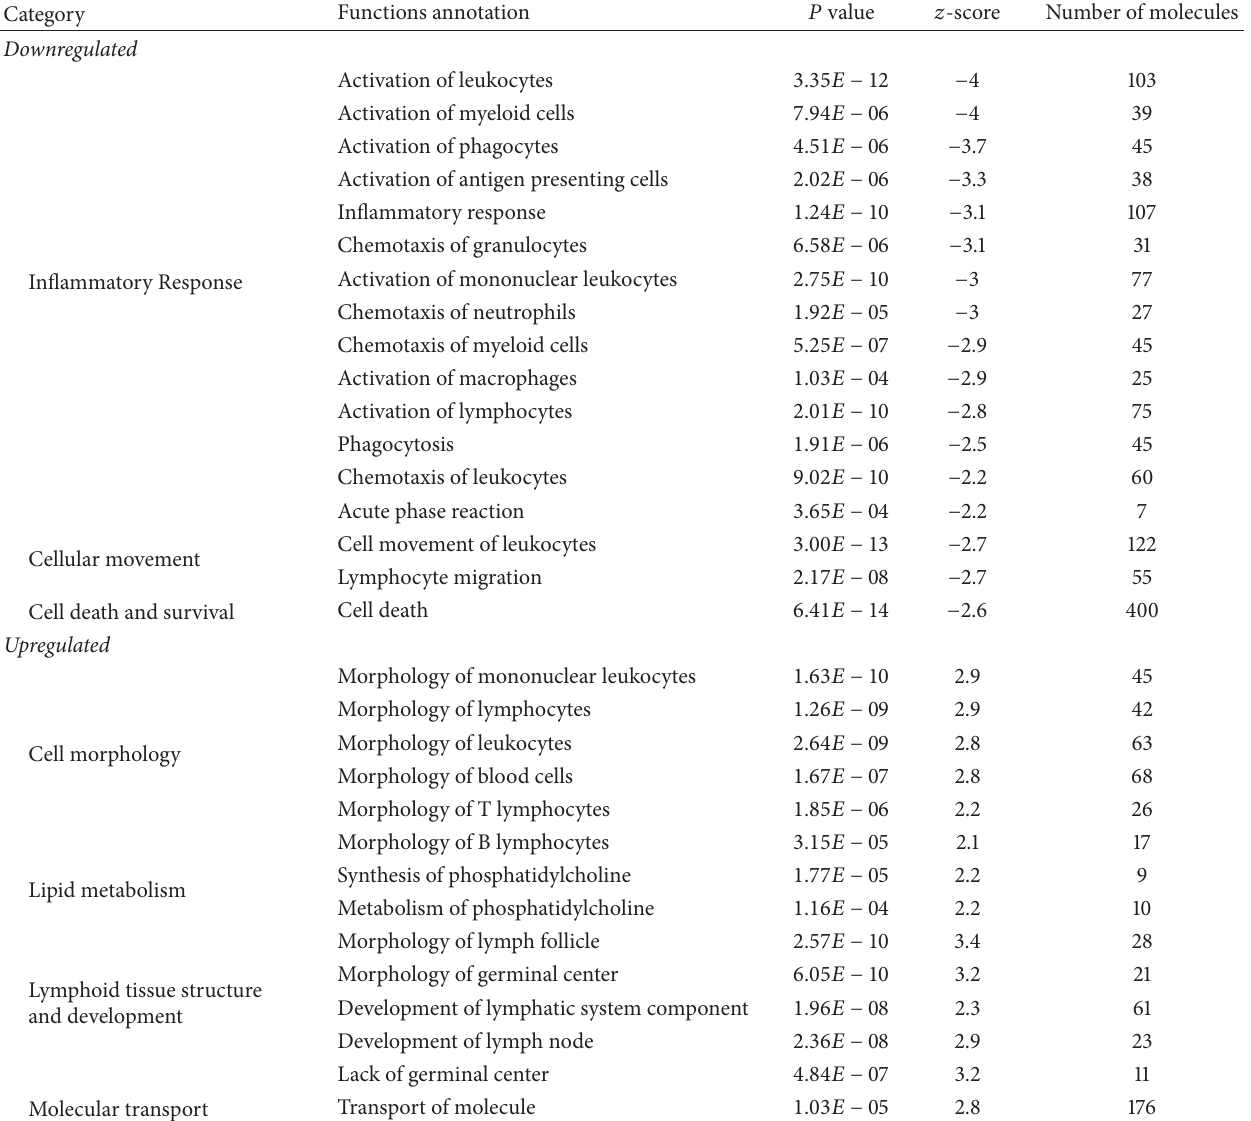
Table 1: 𝑧 -score based functional prediction of